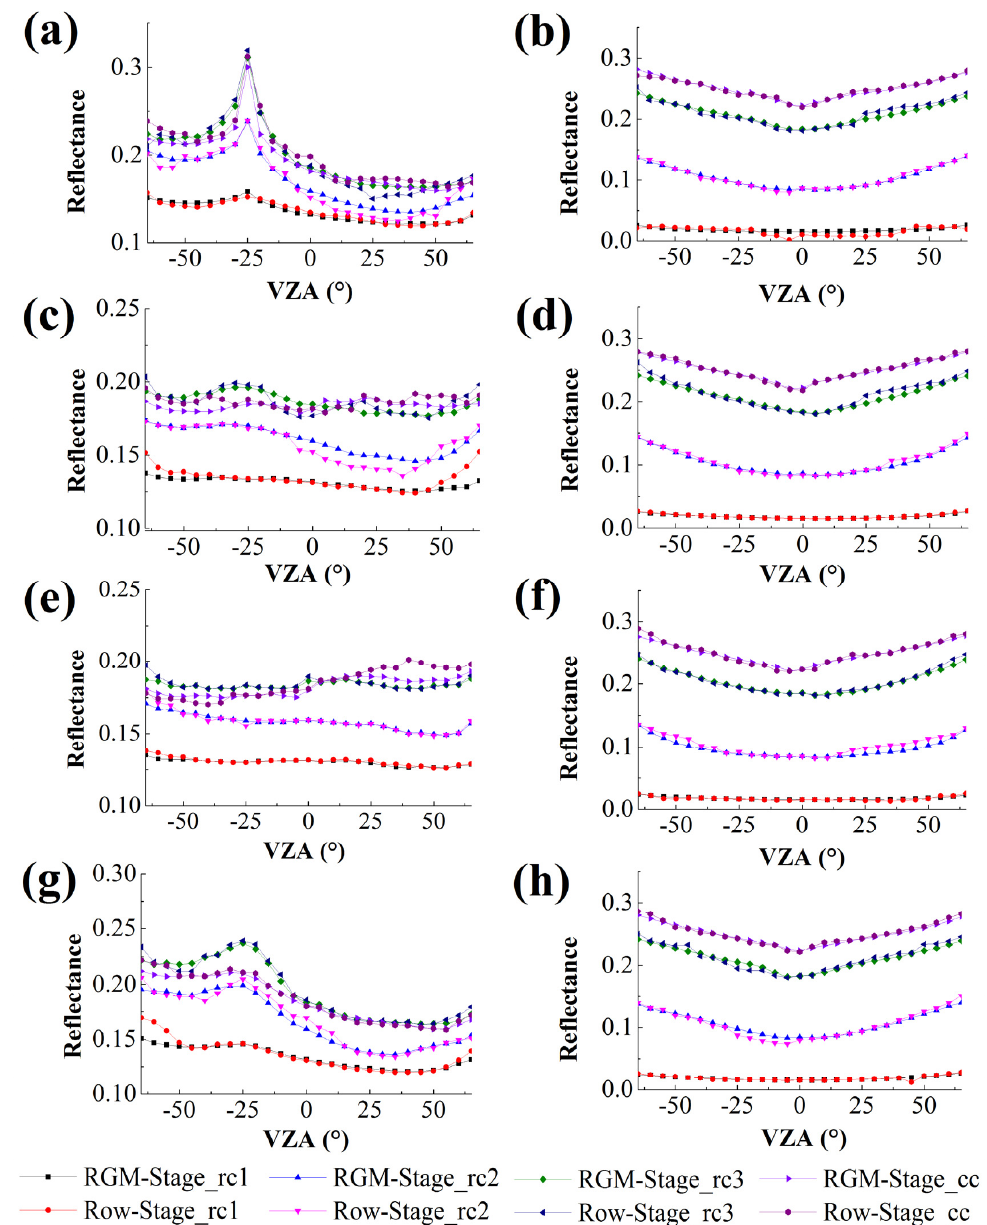
Figure 7. The distribution of reflectances in the single scattering in the NIR band and the multiple scattering in the NIR band simulated by the RGM model and the row model in four viewing modes: ( a ) principal plane (PP) mode in the single scattering in the NIR band, ( b ) principal plane (PP) mode in the multiple scattering in the NIR band, ( c ) orthogonal plane (OP) mode in the single scattering in the NIR band, ( d ) orthogonal plane (OP) mode in the multiple scattering in the NIR band, ( e ) along-row plane (AR) mode in the single scattering in the NIR band, ( f ) along-row plane (AR) mode in the multiple scattering in the NIR band, ( g ) orthogonal row plane (OR) mode in the single scattering in the NIR band, and ( h ) orthogonal row plane (OR) mode in the multiple scattering in the NIR band. Here, VZA is the viewing zenith angle.